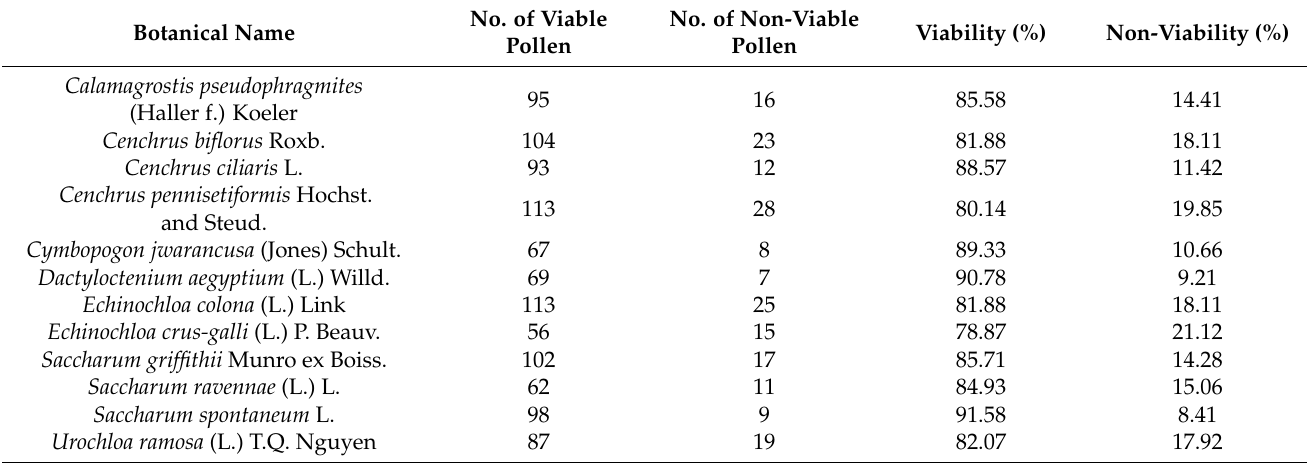
Table 2. Pollen viability and non-viability percentages for salt-tolerant